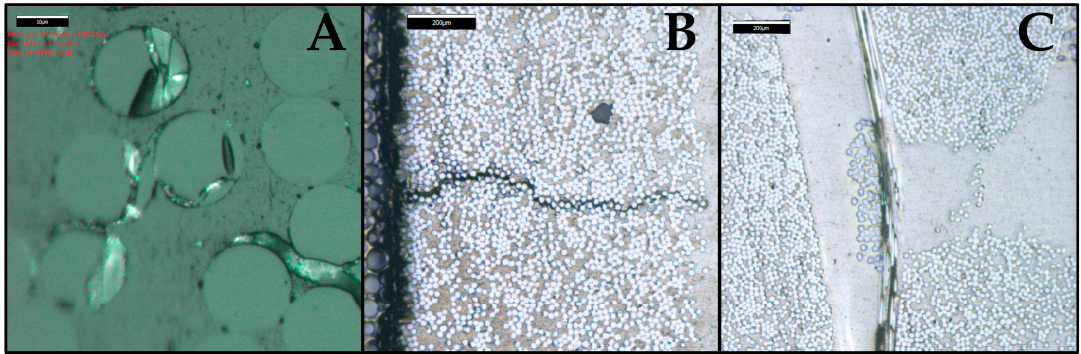
Figure 11. Micrograph of a composite sample exposed to water for 6673 h at 60 °C. The micrograph indicates the ( A ) fiber / matrix debondings; ( B ) matrix transverse cracks; ( C ) splitting along the fibers.